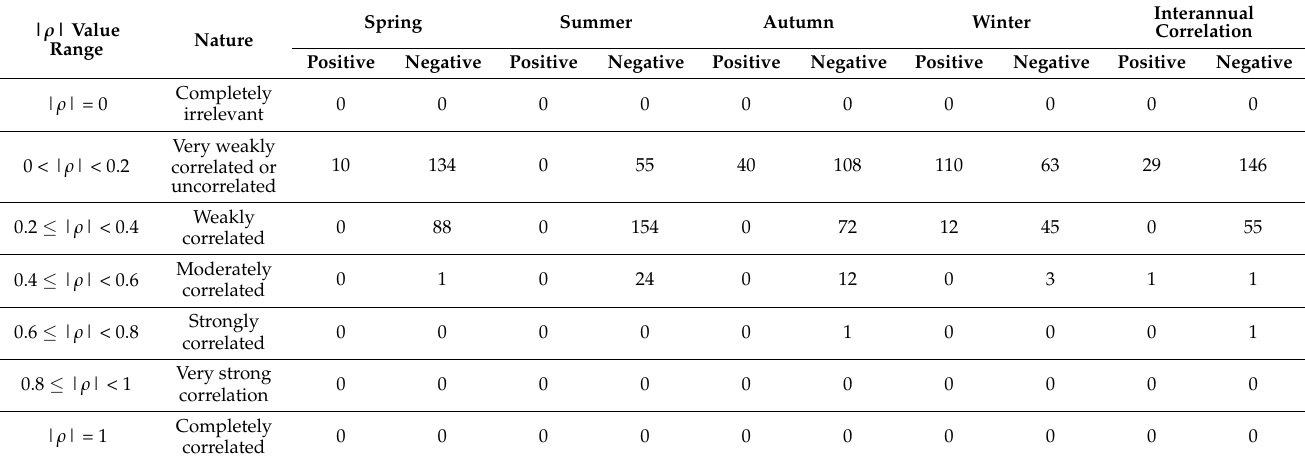
Table 3. Distribution of the number of stations corresponding to the ρ -value in the Huaihe River